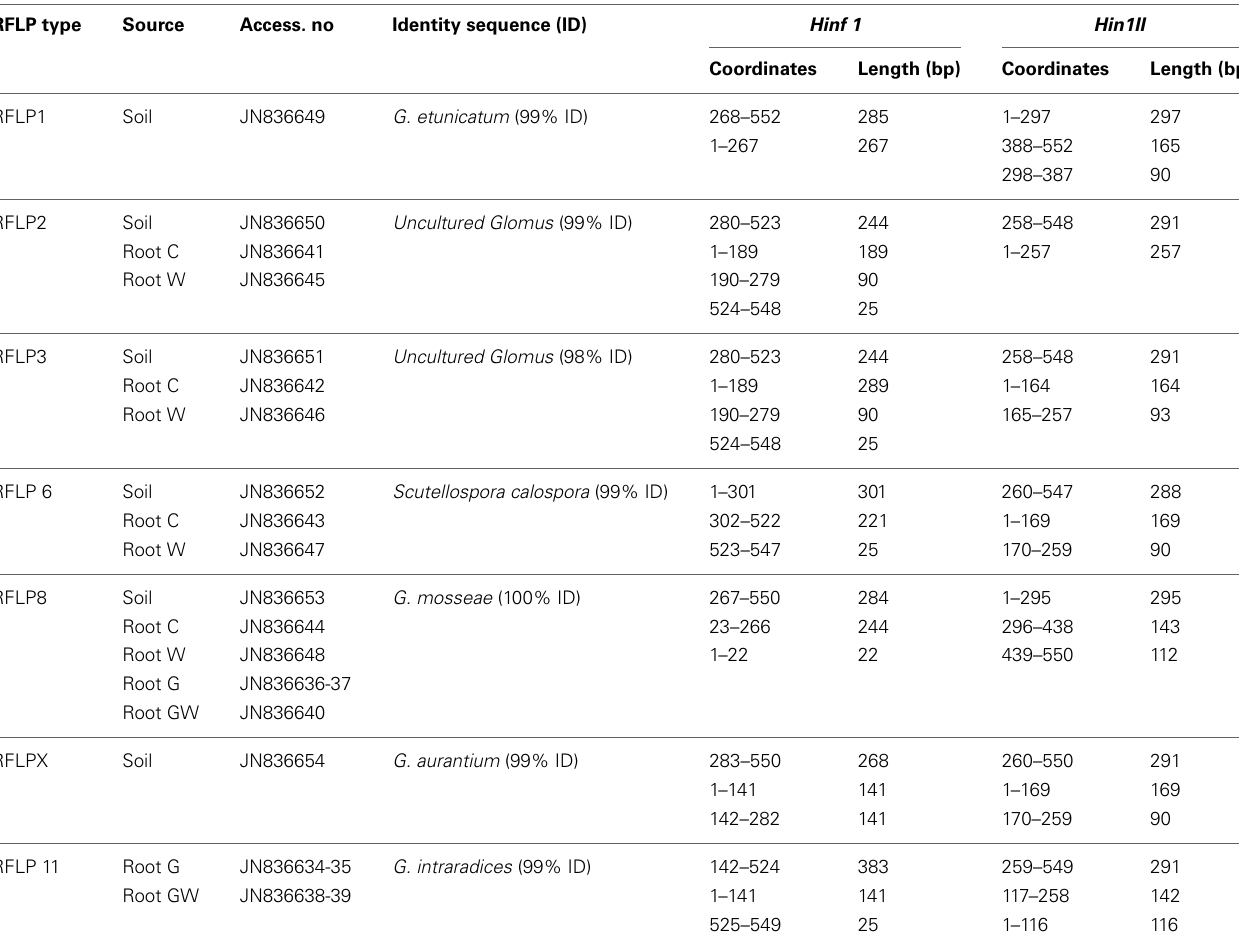
Table 2 | RFLP types found in the soil Haplic Chernozem and in plant roots from the treatments C (control plants), W (maize plants characterized by 3 weeks root feeding of WCR larvae), G (maize plants mycorrhized by GI ) and GW (maize plants mycorrhized by GI and characterized by 3 weeks root feeding of WCR larvae); accession numbers; sequence identity; AMF-18S rRNA gene fragment coordinates and restriction fragment lengths obtained with the enzymes Hinf1 and Hin1II by virtual digestion at BioLabs web